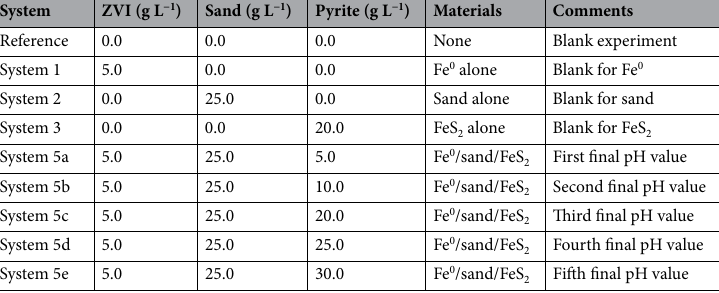
Table 2. Overview on the nine (9) investigated